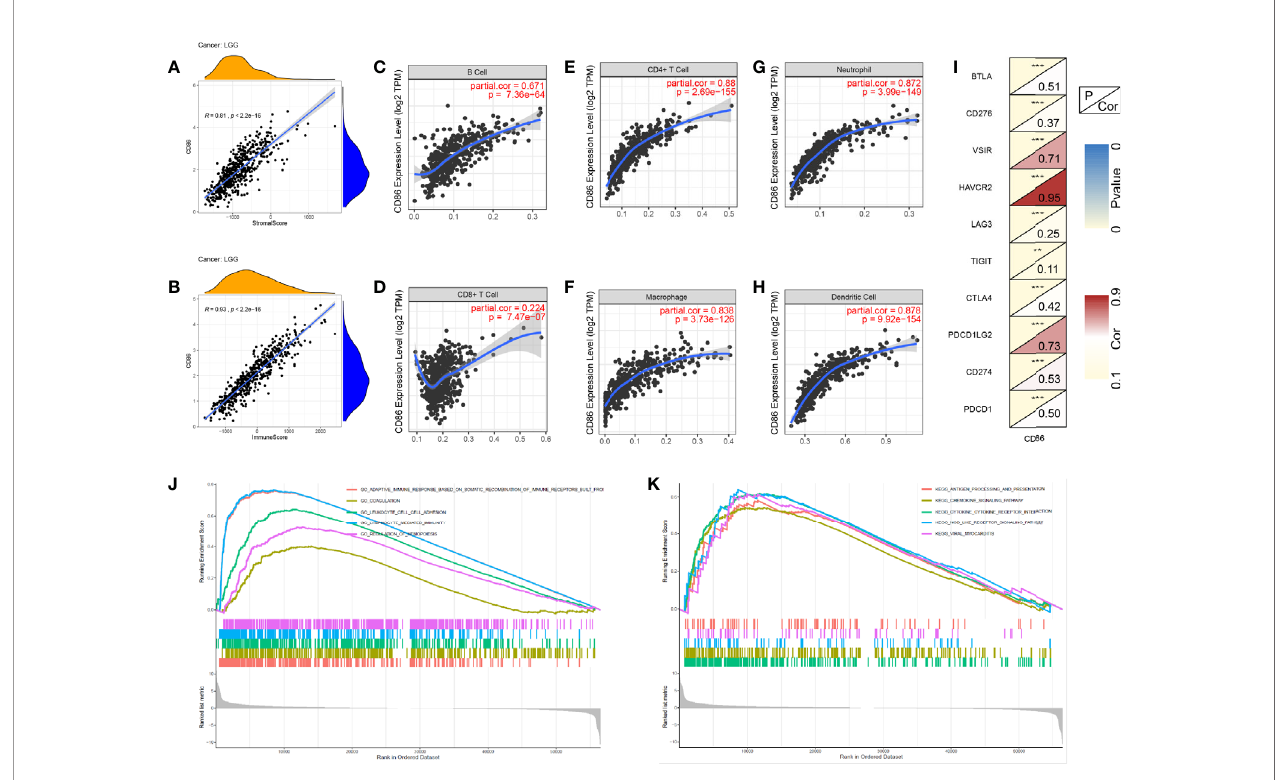
FIGURE 8 | Exploration of CD86-related tumor immunity and GSEA. (A) Correlations between CD86 expression and Stromal Score. (B) Correlations between CD86 expression and Immune Score. Correlations between CD86 expression and different immune cells: B cell (C) , CD8 T cell (D) , CD4 T cell (E) , macrophage (F) , neutrophil (G) , and dendritic cell (H) . (I) Correlations between CD86 expression and different immune checkpoint molecules. (J) GSEA of GO terms. (K) GSEA in KEGG pathway. **p<0.01,